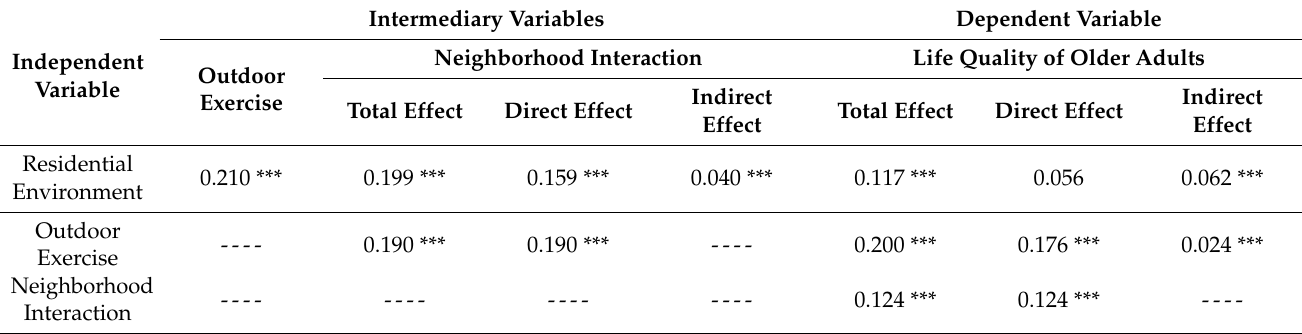
Table 3. Total effect, direct effect and indirect effect of full sample model.